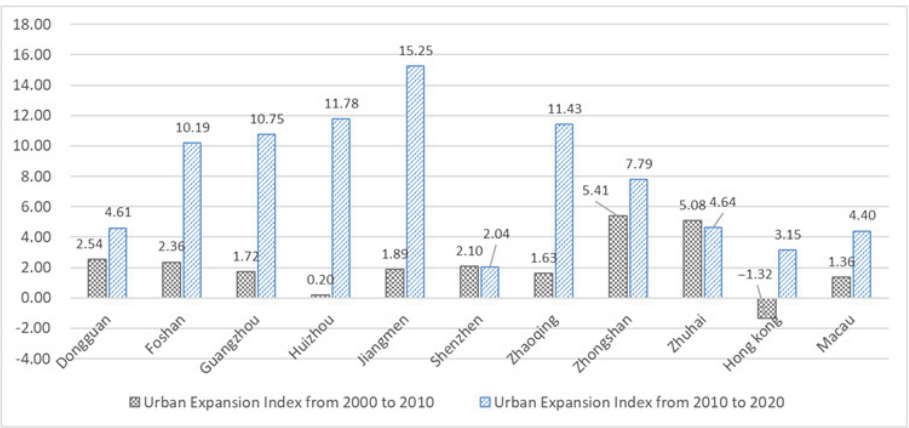
Figure 6. Urban Expansion Index of the GHM-GBA from 2000 to 2020.